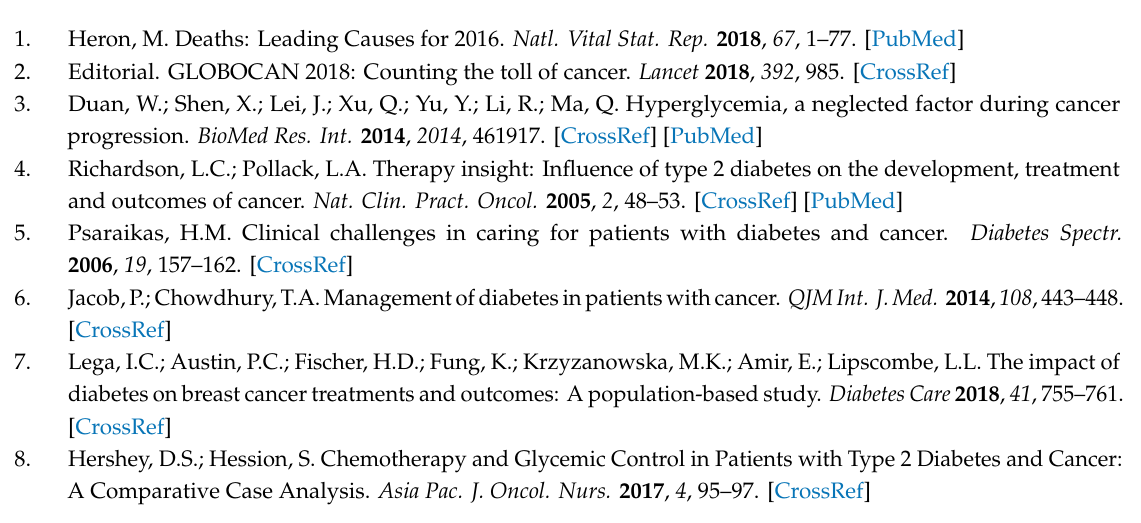
Figure S1: Metabolic disorders and cytokine signaling in cancer, Figure S2: Combinatorial e ff ect of hyperglycemia associated alterations in cancer, Table S1: Increased mortality of di ff erent cancers under hyperglycemic / diabetic